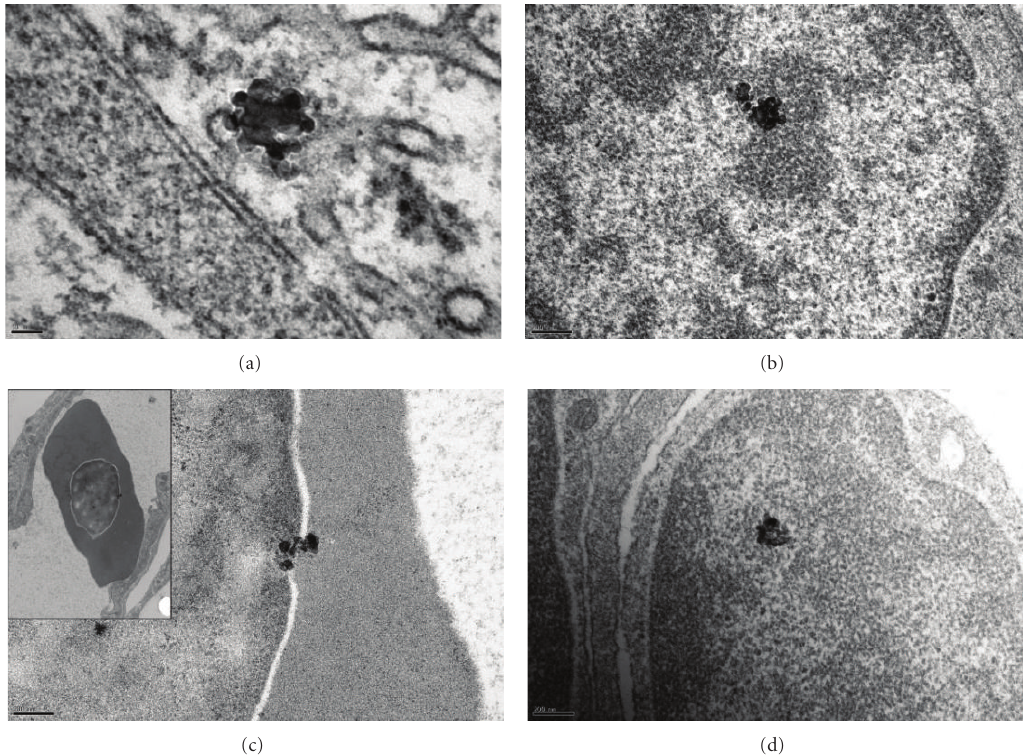
Figure 9: TEM image of the gill of the common carp ( Cyprinus carpio ) exposed to Ag-NPs for 96 h. (a) 25 µ g/L. Gill lamella. (b) 50 µ g/L. Nucleus. (c) 100 µ g/L. Blood corpuscle. (d) 100 µ g/L.